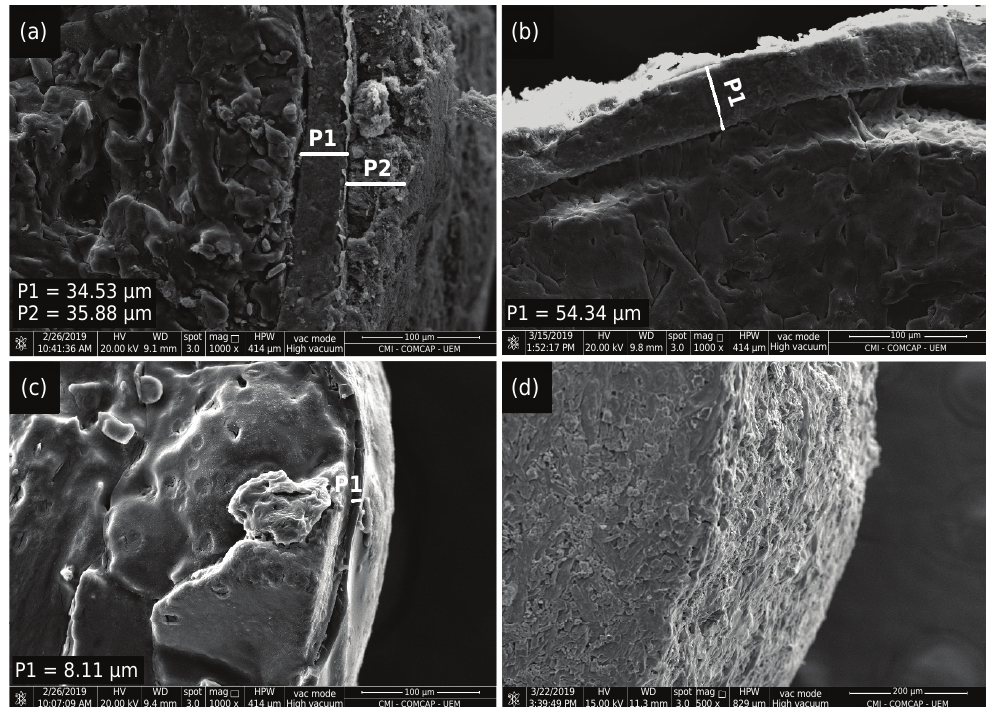
Figure 1. Electron micrographs of the PCUs used as N sources for corn. FortBlen ® with double coating (a); FortBlen ® with single coating (b); Agrocote ® with single coating (c), and Kimcoat ® without coating